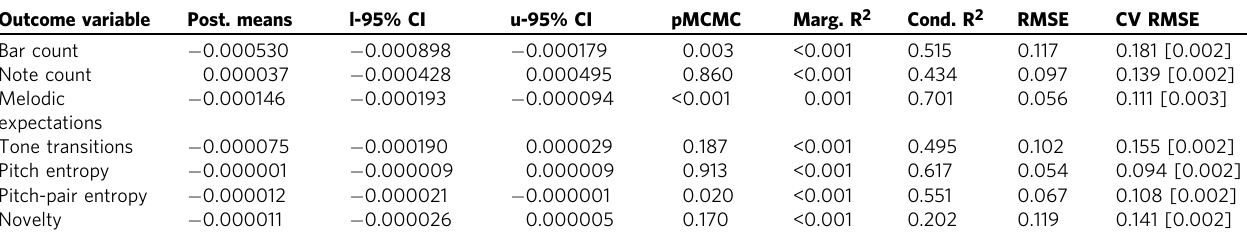
Table 3 Results of setting-level models predicting measures of tune complexity from popularity ( N set adds, n = 12,422). Outcome